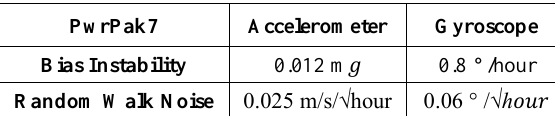
Table 2 . PwrPak7 performance specification.